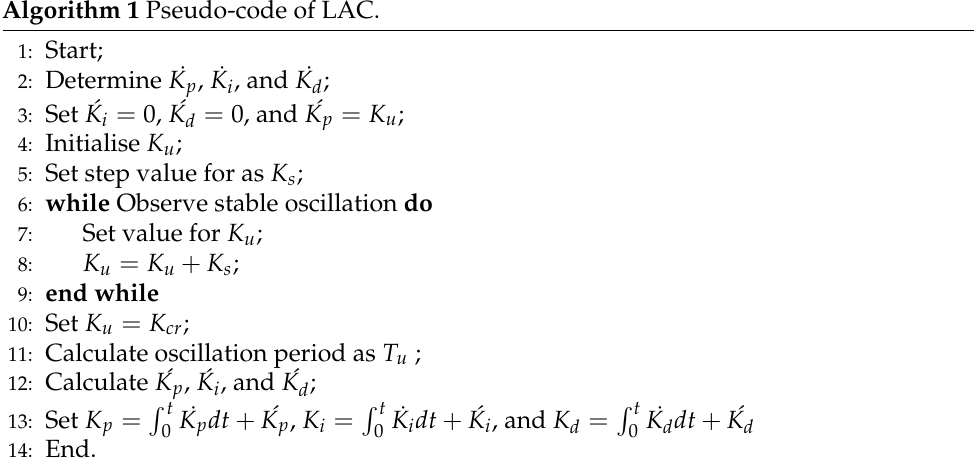
Algorithm 1 expresses the overall pseudo-code of the LAC strategy. K s is the proportional step to increase K u gradually until the ultimate gain is obtained. Algorithm 1 Pseudo-code of LAC.